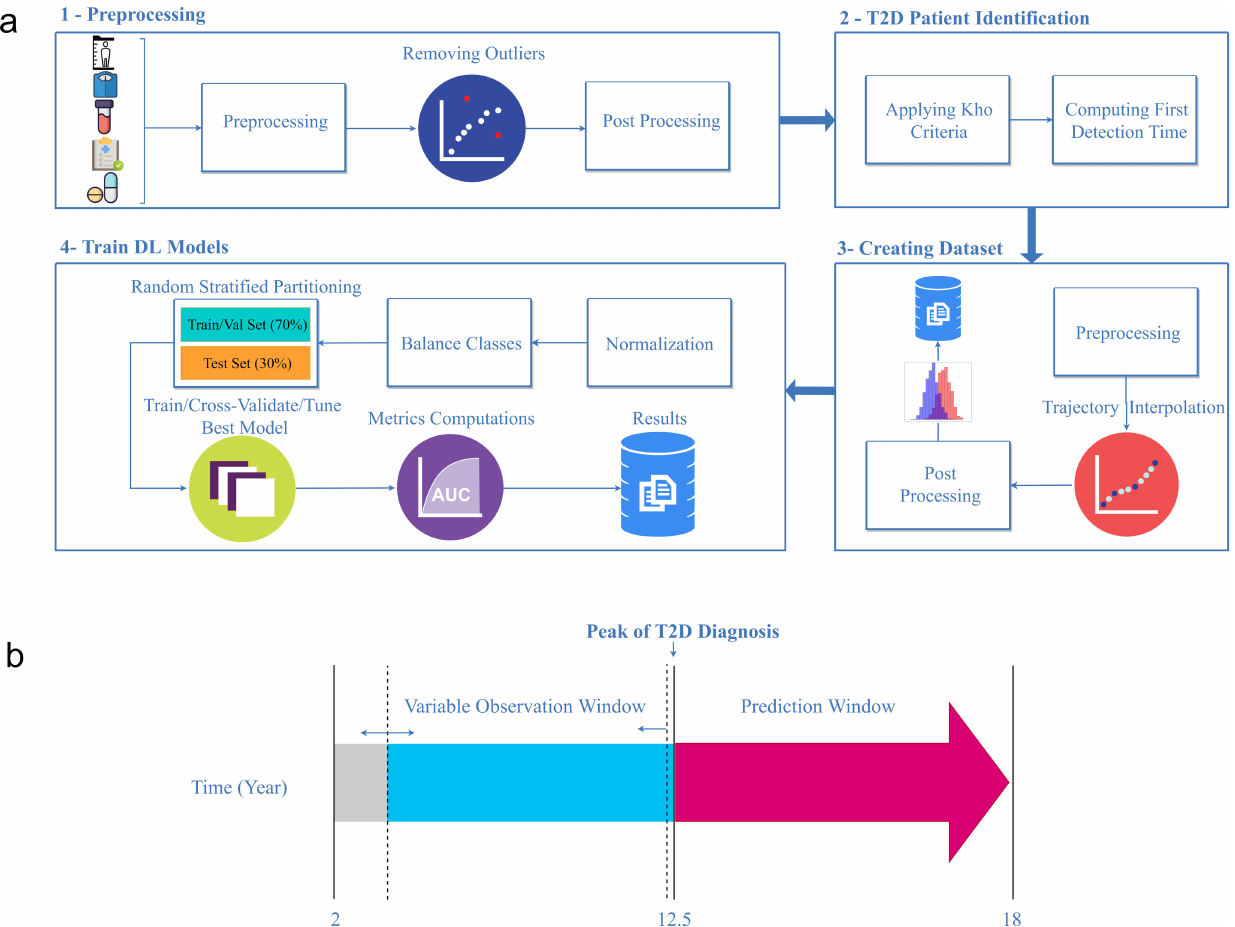
Fig. 4 Modeling real-world pediatric type-2 diabetes (T2D) work fl ow. a Longitudinal weight and height data were extracted from the EHR. Height and weight outliers were removed and patients with <2 BMI records were excluded. Next, patients were labeled as underweight, normal weight, overweight, obese, and severe-obese according to Centers for Disease Control criteria, and were classi fi ed as those that developed T2D or did not develop T2D according to the eMERGE criteria 44 . Trajectories were then harmonized such that each trajectory consisted of a single BMI record per year. Trajectories were truncated to exclude any records at or after the average age of pediatric T2D onset and any records after a patient ’ s T2D diagnosis. Because deep learning models require uniform trajectory lengths, multiple datasets were created across a variety of different age ranges. For each dataset a TSF-CNN model was tuned using 20% of the training set and trained using tenfold cross-validation; the mean and standard deviation of validation and test AUCs were calculated. Subsequent modeling steps were consistent with those shown in Step 2 of Fig. 1. b Depicts the observation and prediction window de fi nitions. The observation window varied from 2 years old to average age of T2D in pediatric patients (12.5 years old), and the prediction window was fi xed from 13 to 18 years